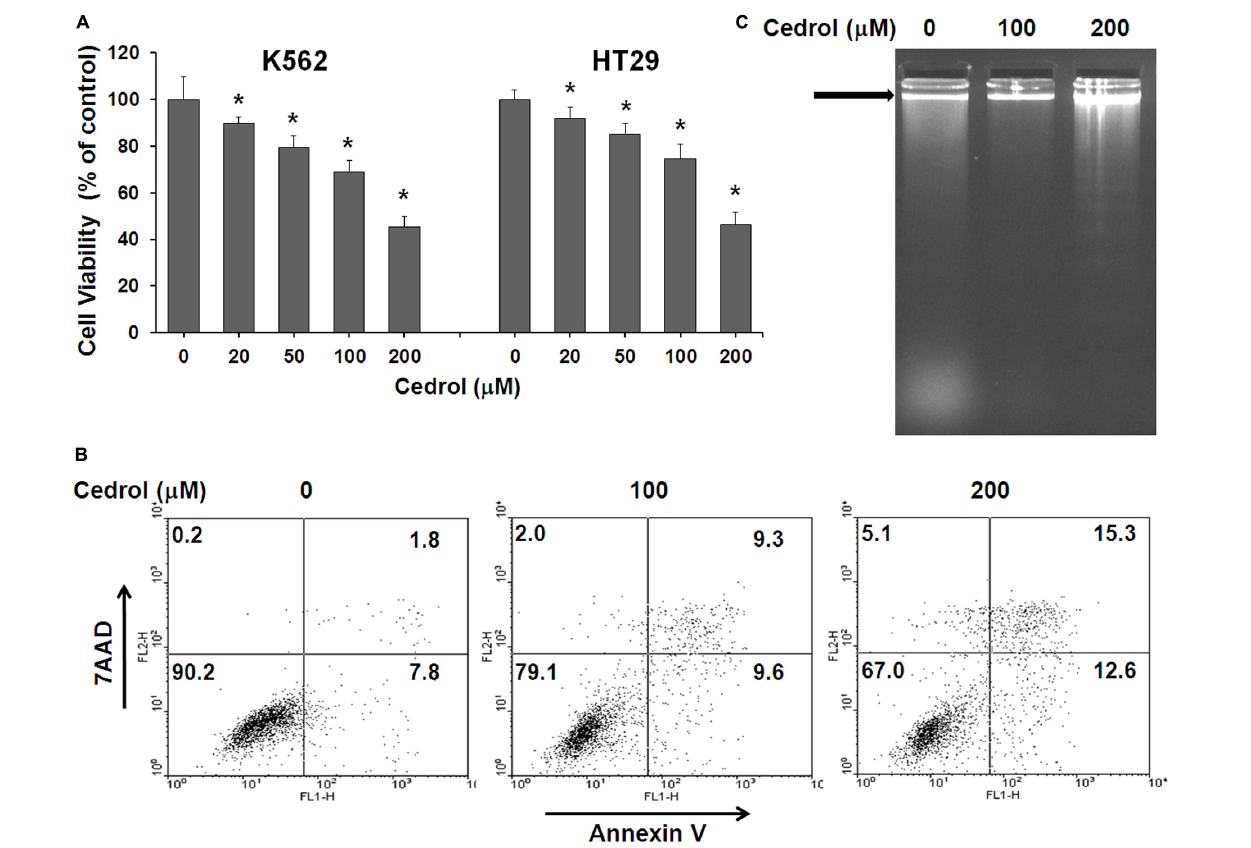
FIGURE 1 | Effect of cedrol on growth of K562 and HT29 cells. (A) K562 and HT29 cells were treated with vehicle control (0.1% DMSO) and indicated concentrations of cedrol for 48 h. Cell viability was assayed as described in Materials and Methods, and viable cells were denoted as a percentage of vehicle controls (VH). The data are expressed as means ± SD of six wells from the 96-well plate, and the whole experiment was independently repeated for three times. * P vs. VH. (B) K562 cells were treated with VH or cedrol for 18 h and then stained with annexin-V/7AAD. Apoptosis was detected for flow cytometric analysis. * P